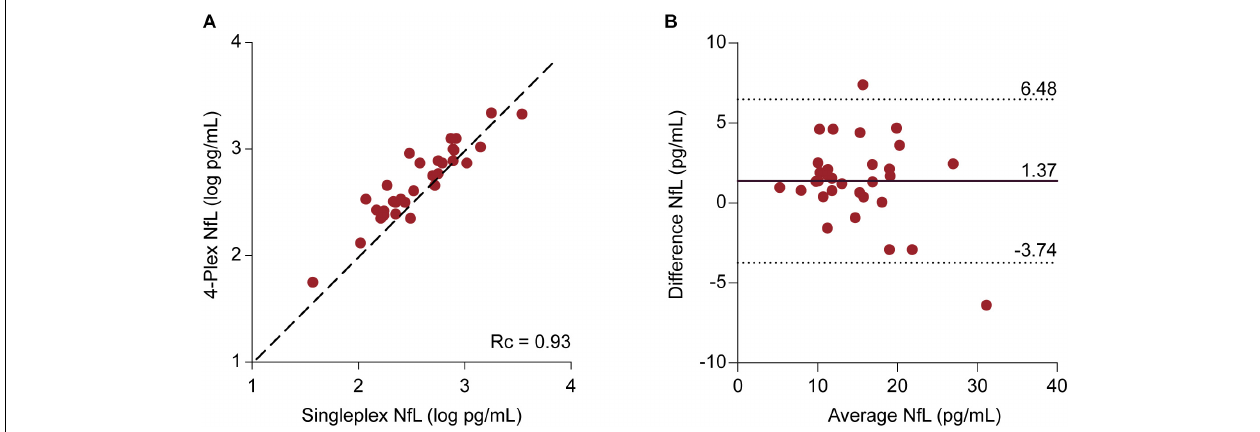
FIGURE 4 | Comparison between NfL measurements derived from the 4-Plex and NfL singleplex assay | (A) Individual log - transformed NfL from the 4-Plex and NfL singleplex were plotted against each other. Lin’s concordance correlation coefficient ( r c ) evaluates the degree to which pairs of measurements fall on the 45 ◦ line, here represented as the discontinuous line, through the origin. (B) Bland–Altman Plot. Each patient sample is represented as a point on the graph. The difference between the two measurements (Neurology 4-Plex assay – Neurofilament-light singleplex assay) is plotted against the mean of the two measurements [(Neurology 4-Plex assay + NfL singleplex assay)/2]. The mean difference (1.37 pg/mL) is represented by the black line. The upper (6.48 pg/mL) and lower ( − 3.74 pg/mL) 95% agreement intervals, designated with discontinuous lines, are shown. These statistical limits were computed using the mean and the standard deviation (2.60 pg/mL) of the differences between two